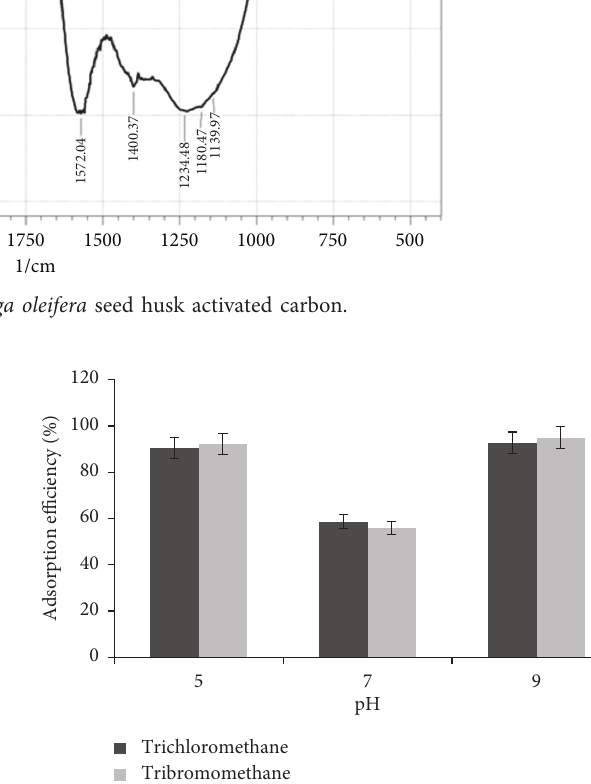
Figure 3: Effect of pH on adsorption of trichloromethane and tribromomethane in simulated experiment.